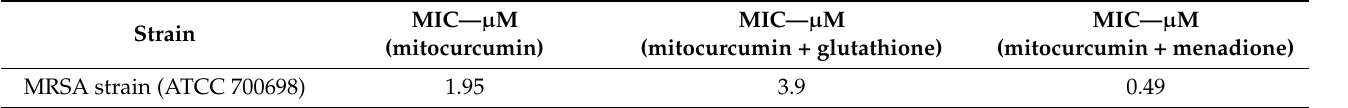
Table 3. The influence of reduced glutathione and menadione for the antibacterial activity of